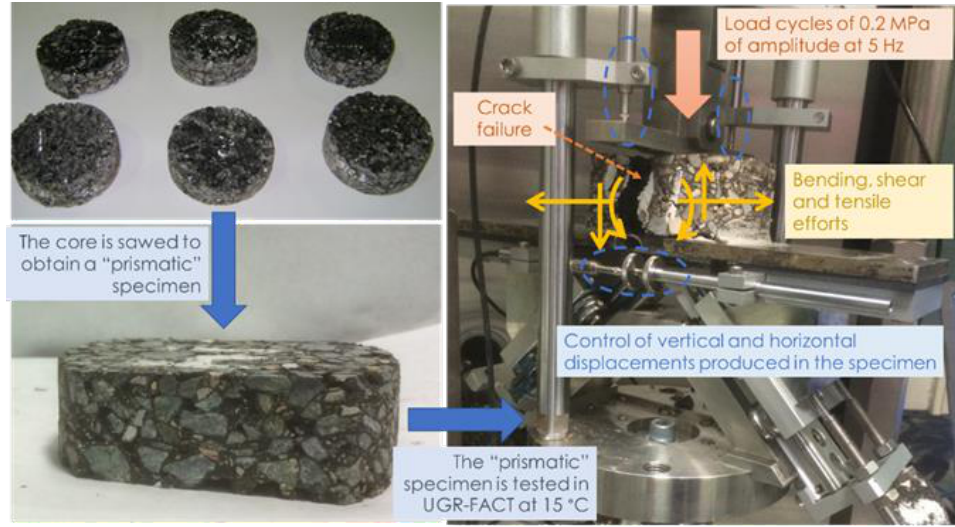
Figure 6. Schema of the UGR-FACT method.